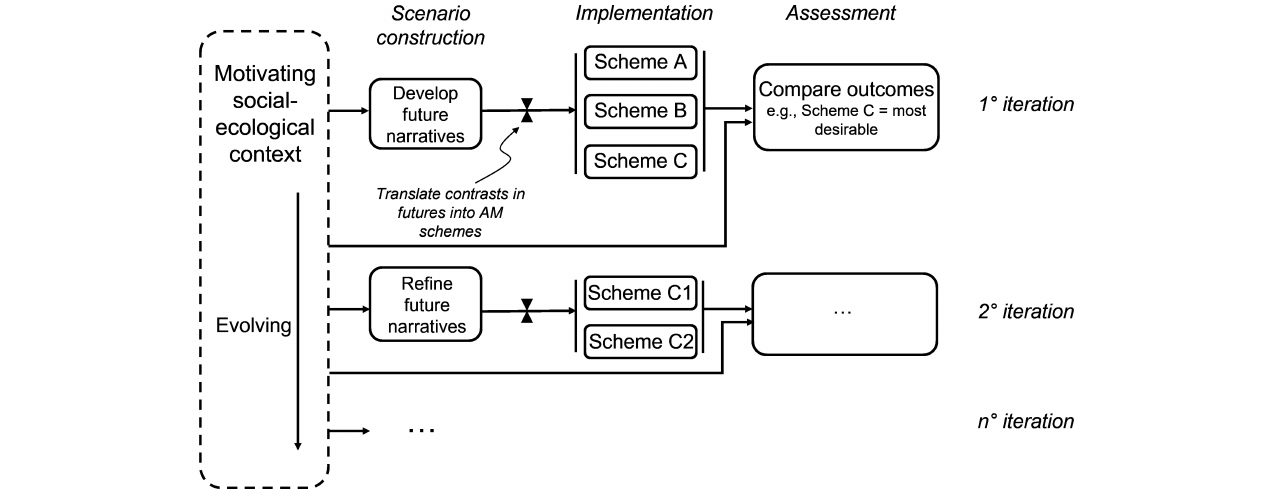
Fig. 1 . Graphic representation of the process for carrying out iterative scenarios. The initial phase is scenario construction that develops future narratives based around key uncertainties around what will be desirable and plausible in the future for the system being managed and the greater motivating social-ecological context. The first iteration (1°) involves consideration of major contrasts about how the future will unfold and what will be desirable and plausible. A critical next step is translating these future narratives into testable adaptive management (AM) schemes (represented by the hourglass symbol) that seek to learn about natural resource functioning as it will be necessary to inform multiple future management needs. Several schemes are implemented and tested simultaneously (ideally) in a horse-race style that will inform management for different social-ecological futures. Assessment phase is next, which involves the selection of the most desirable scheme based on learning about their performance and consideration of evolving motivating social-ecological context. The most desirable scheme emerges as a broad vision that will likely require further learning about uncertainties in social-ecological futures. Thus, the process is iterated starting with refined future narratives constructed around the most desirable scheme from the previous iteration and again considering further evolution in the motivating context. Alternatively, shifts in the motivating social-ecological context, e.g., a high-level policy change, could result in refining and further testing a previously less desirable scheme. The number of schemes to test at the implementation phase across iterations is dependent on the goals and capacities of the actors and their system’s complexity. The scenario construction-implementation- assessment process is iterated indefinitely, adjusting to the evolving contexts and continual refinement of uncertainties to be resolved. Ellipses graphically represent the ongoing management decisions and actions and the subsequent iteration of the